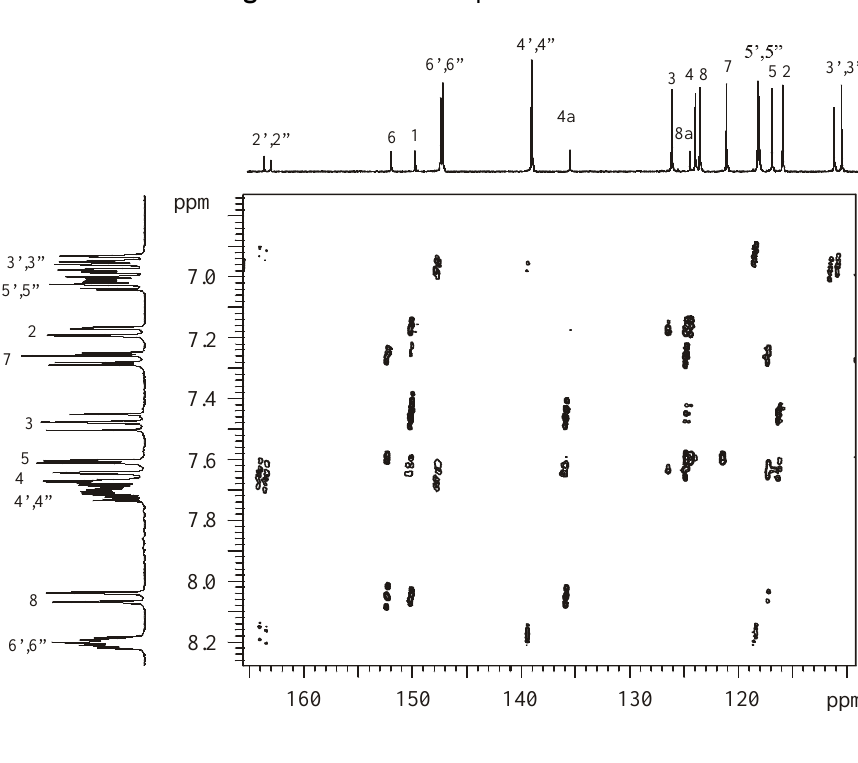
Figure 2. GHMBC spectrum of 3d